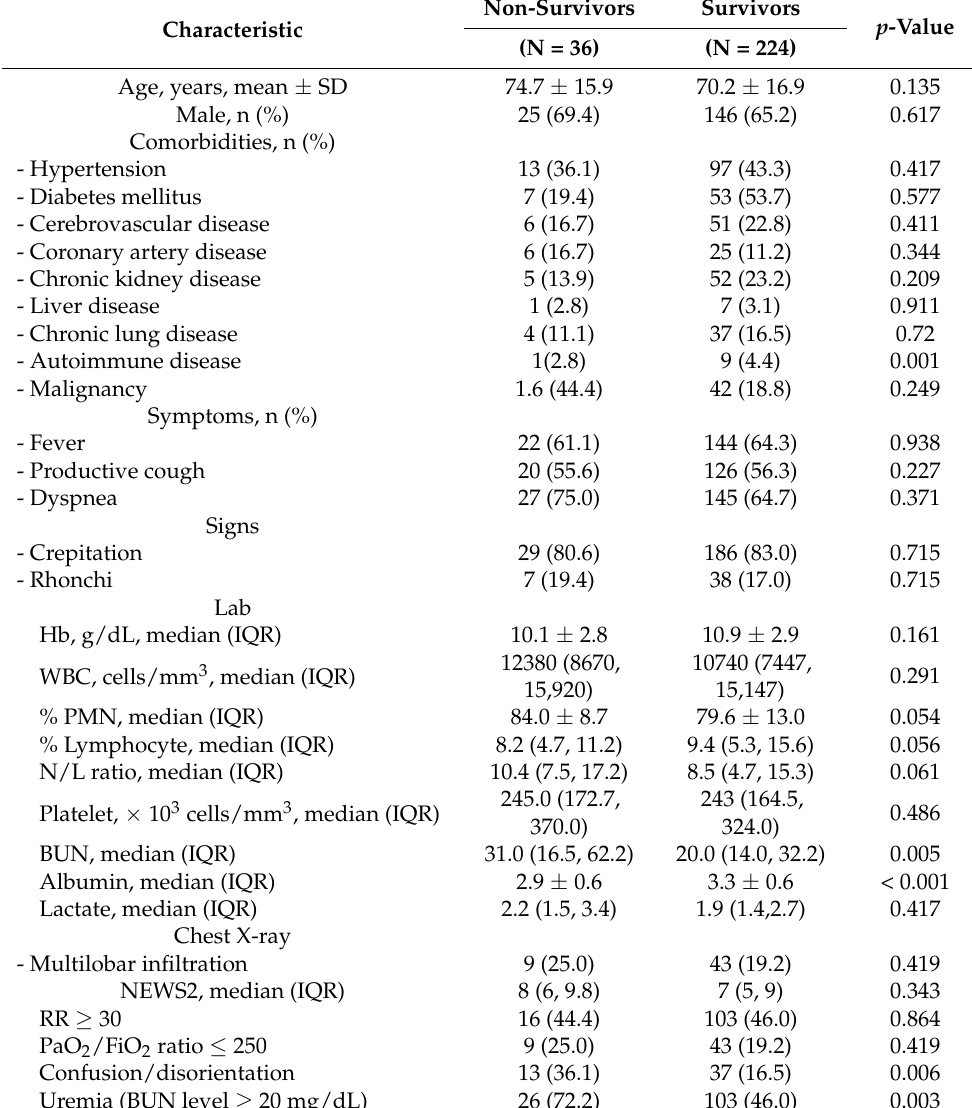
Table 2. Characteristics of patients with community-acquired pneumonia of non-survivors and survivors